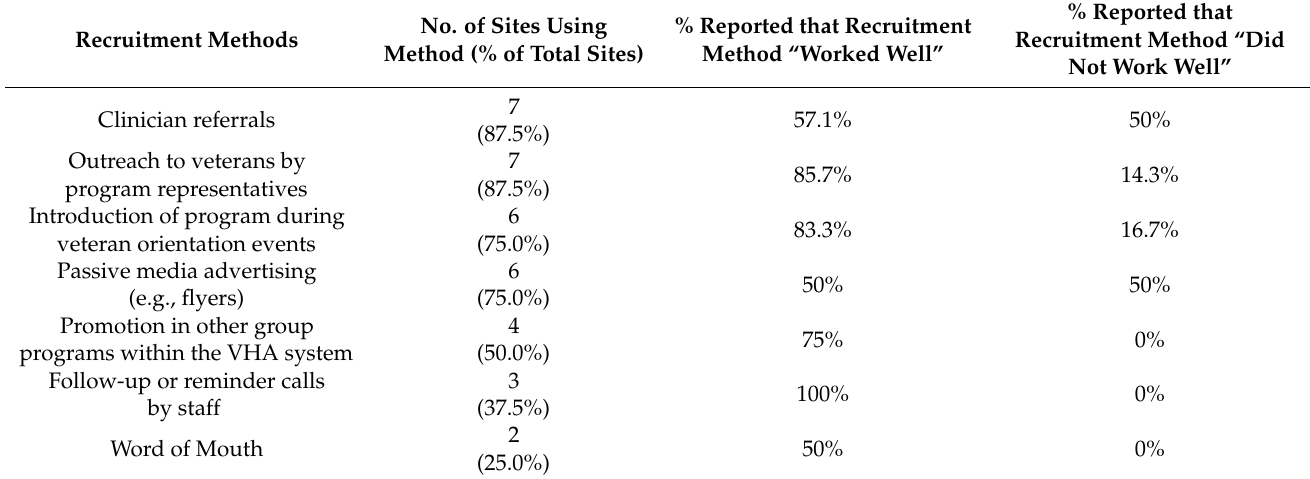
Table 6. Recruitment Methods Utilized by the VHA System for TCMLH Implementation (n =